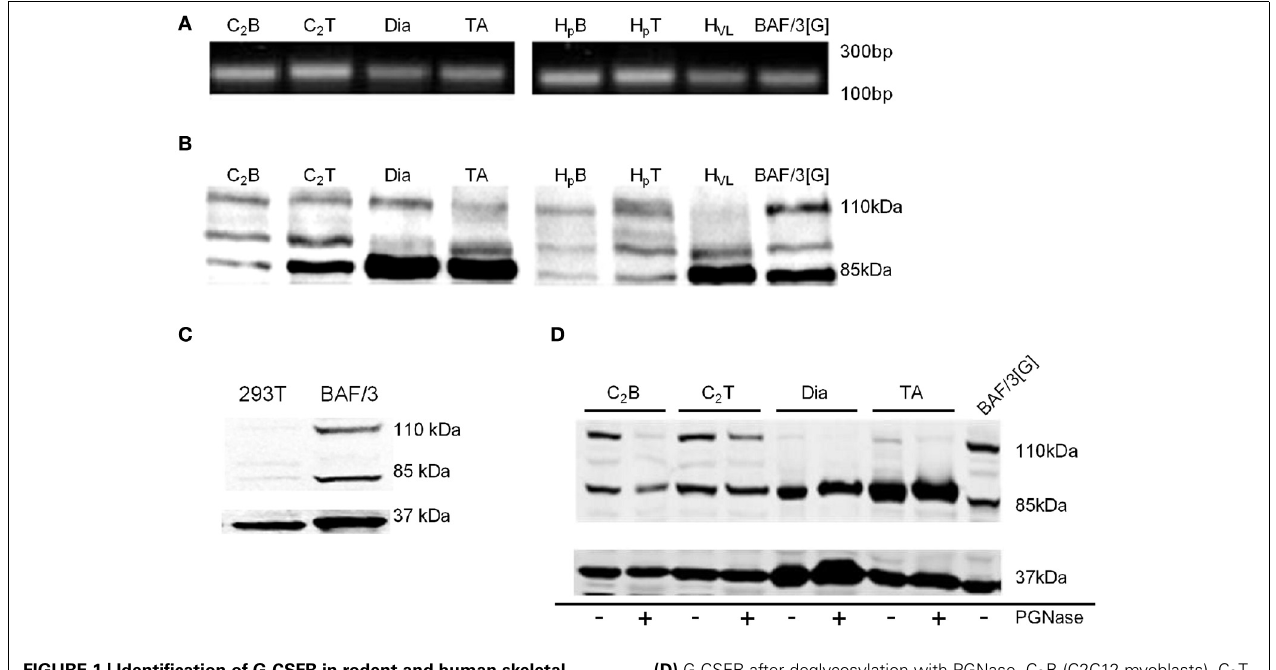
(D) G-CSFR after deglycosylation with PGNase. C 2 B (C2C12 myoblasts), C 2 T (C2C12 myotubes), Dia (diaphragm muscle from C57BL/10 mice), TA (tibialis anterior muscle from C57BL/10 mice), H p B (human primary myoblasts), H p T (human primary myotubes) H VL (human vastus lateralis muscle), BAF/3[G] (murine pro B cell line overexpressing G-CSFR) and 293T (human embryonic kidney 293T cell line). Experiments were performed in